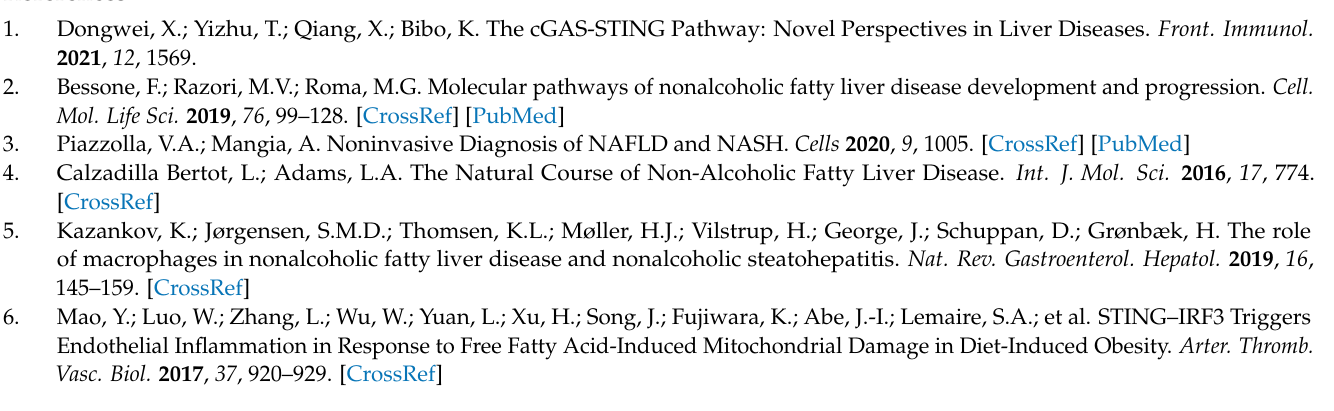
control, Table S2: Functional enrichment analysis DEGs between NASH, steatosis, and normal groups Table S3: Functional annotation table by Functional Annotation Tool DAVID Bioinformatics Resources 6.8, NIAID/NIH, Table S4: Putative interaction between miRNA-6888-5p and the selected mRNA by Target scan database, Table S5: Details of the GSE89632 datasets retrieved from the GEO database; Table S6: Reagents used in the biochemical parameters assessment, Table S7: List of primers used for